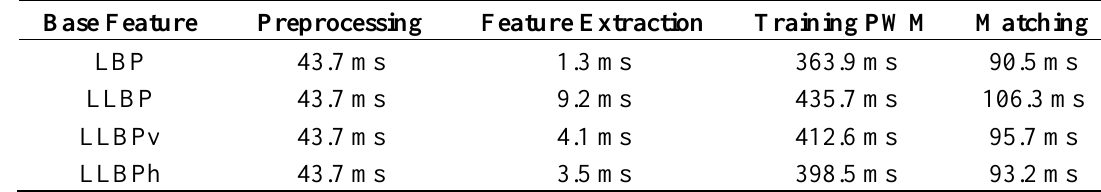
Table 9. The average computation